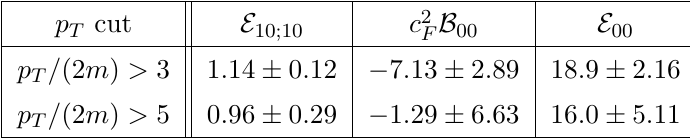
Figure 6 . Dependence on the upper p T cut p max and E 00 determined from fits to cross section data with fixed p min renormalized in the MS scheme at the scale Λ = 1 . 5 GeV, and c F is computed at the same scale with the charm quark mass m c = 1 . 5 GeV. The bands represent the results of the fit for p min and p max T